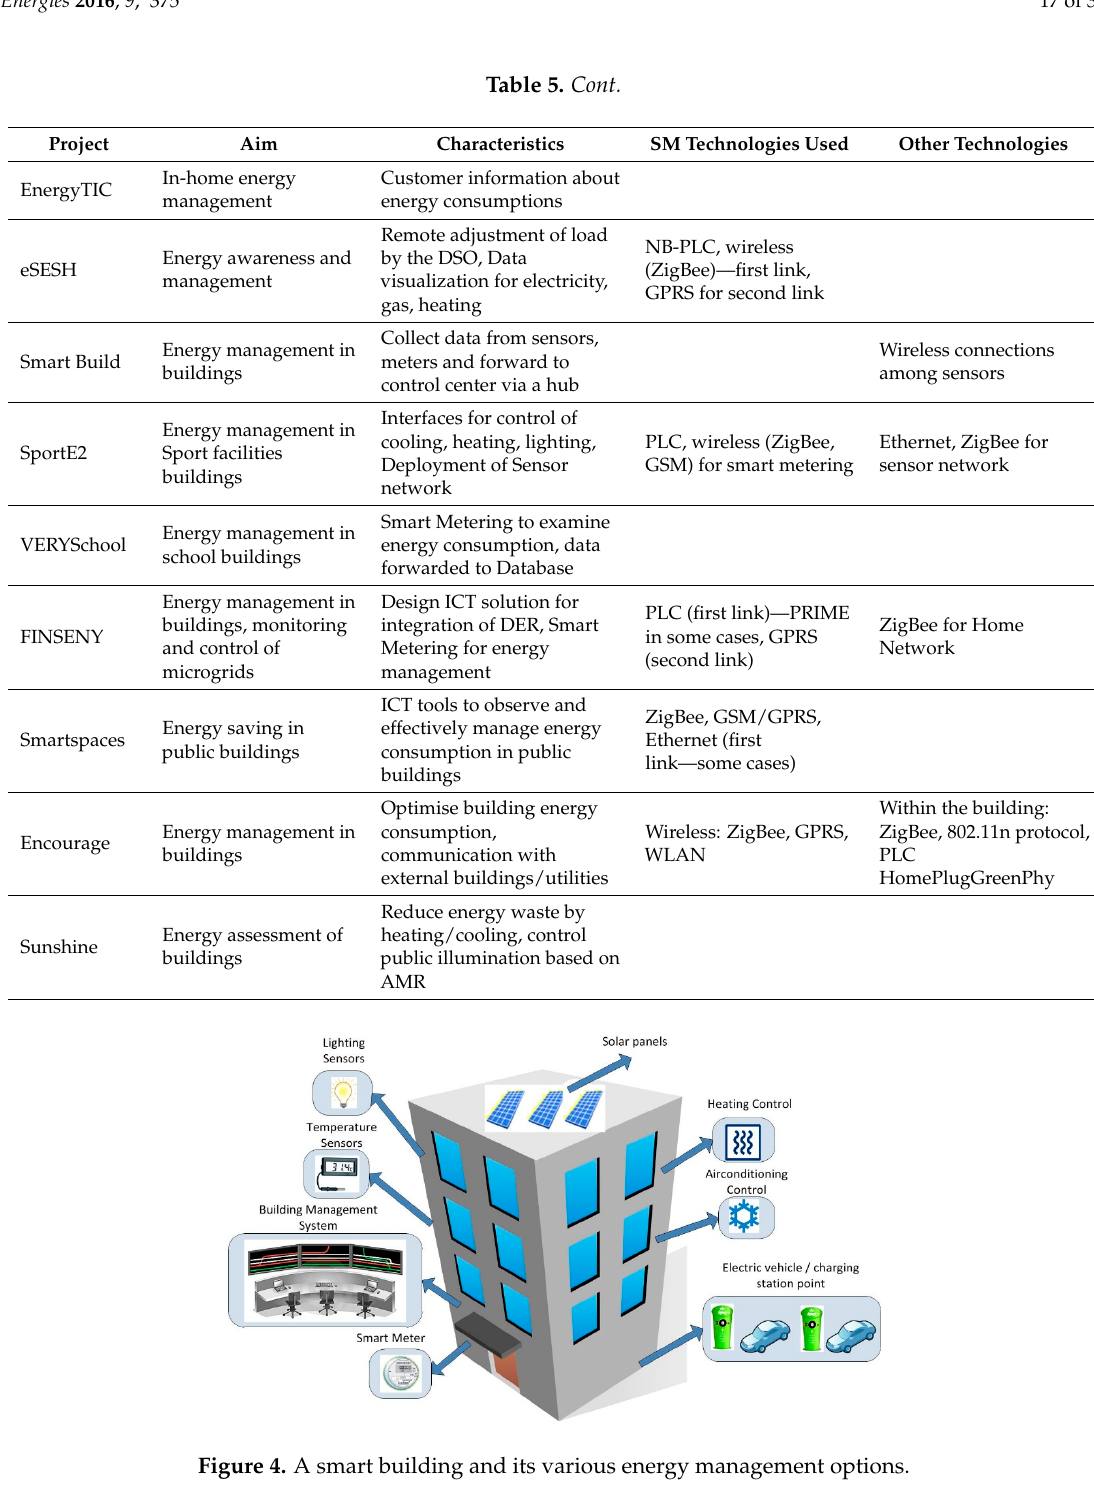
Figure 4. A smart building and its various energy management options.